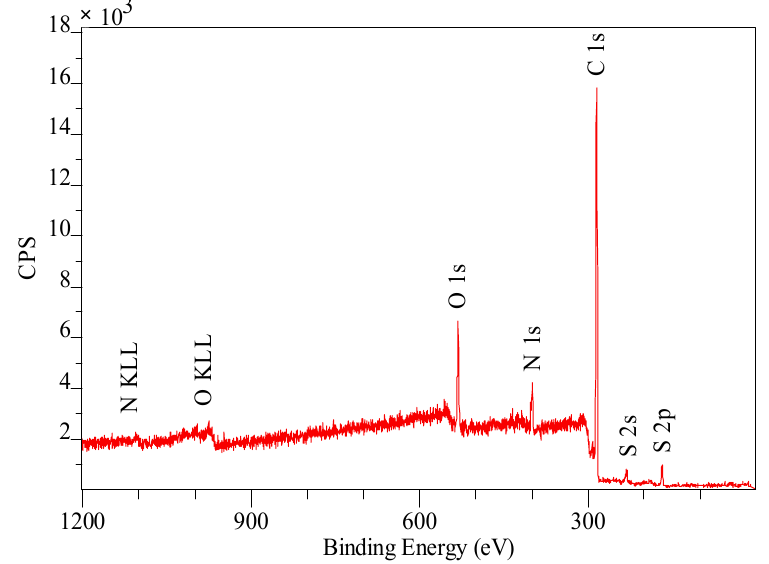
Figure 7. XPS spectrum obtained in a wide range of binding energy made for the Dowex M 4195 before the sorption process. Table 7. The XPS analysis results obtained in the narrow range of binding energy for the Dowex M 4195.